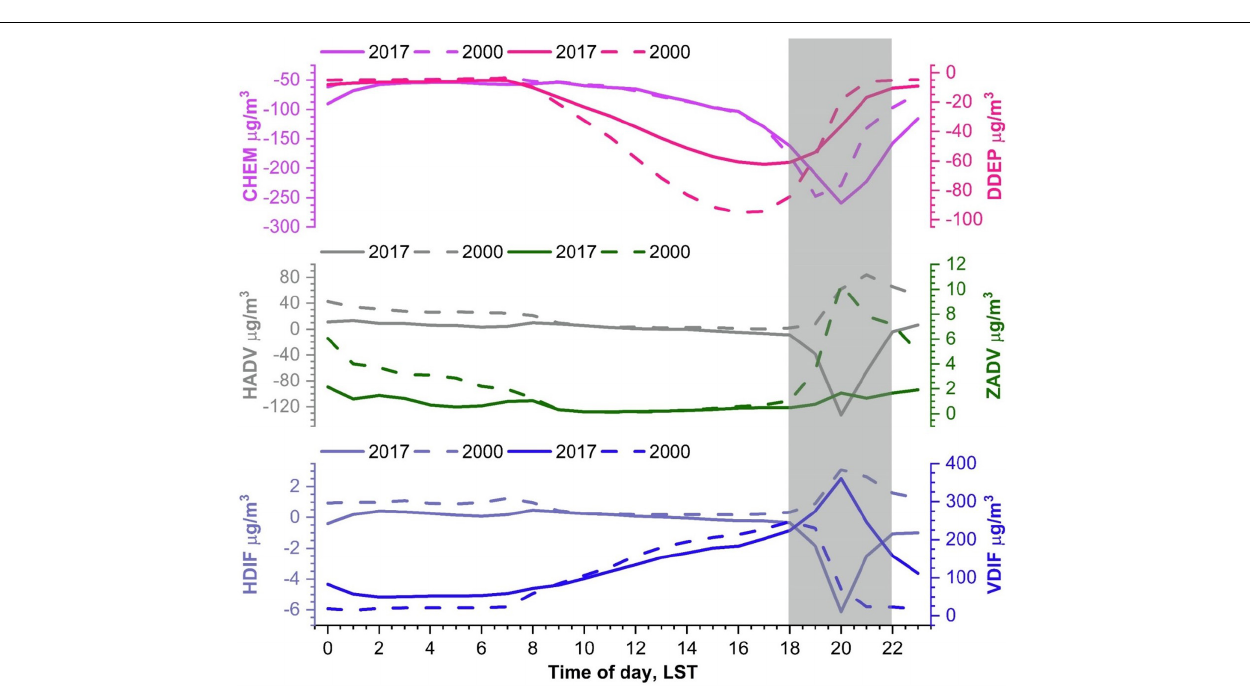
FIGURE 12 | Diurnal pattern of physical and chemical processes for O 3 in 2000 and 2017. The average data was calculated from the value of